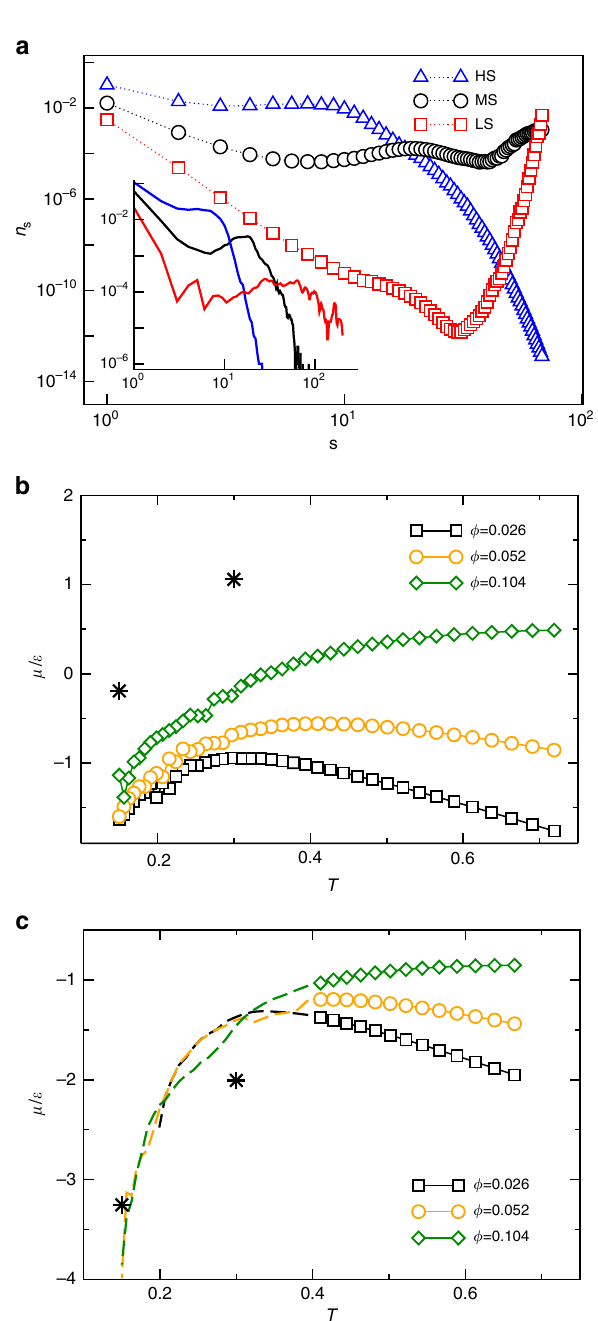
Figure 3 | Clusters and crystalline states. ( a ) Cluster size distribution n s from GCMC simulations up to s ¼ 70 at T ¼ 0.25: HS (triangles), MS (circles) and LS (squares). The inset displays n s at the same T obtained from the MD simulations at f ¼ 0.052 for N ¼ 6912 particles. The lines are a guide to the eye. ( b , c ) The values of the chemical potential of the cristalline states (asterisks) from Table 2 are compared with the one in the cluster phase at different volume fractions, computed by Widom insertion for HS ( b ) and LS ( c ), as a function of temperature. The dashed lines in c refer to the values measured in the region of coexistence of gas and crystalline clusters.